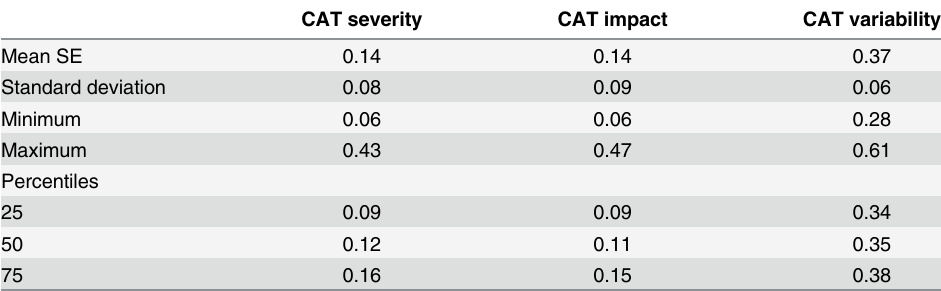
Table 6. Standard errors per CAT dimension (N =